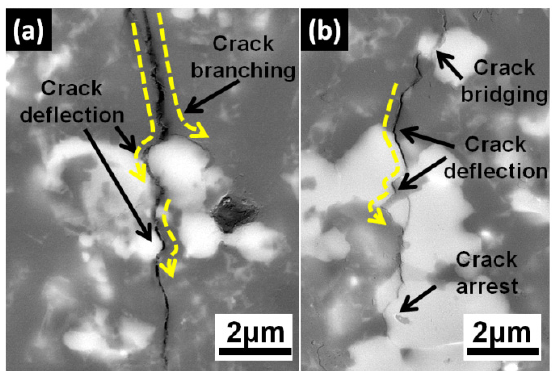
Figure 7. Typical SEM images of crack deflection in Ti 3 SiC 2 densified Si 3 N 4 composites. Table 3. Selected results on mechanical properties of Si 3 N 4 ceramics by pressure-assisted sintering. Vickers Composition Sintering Conditions Hardness